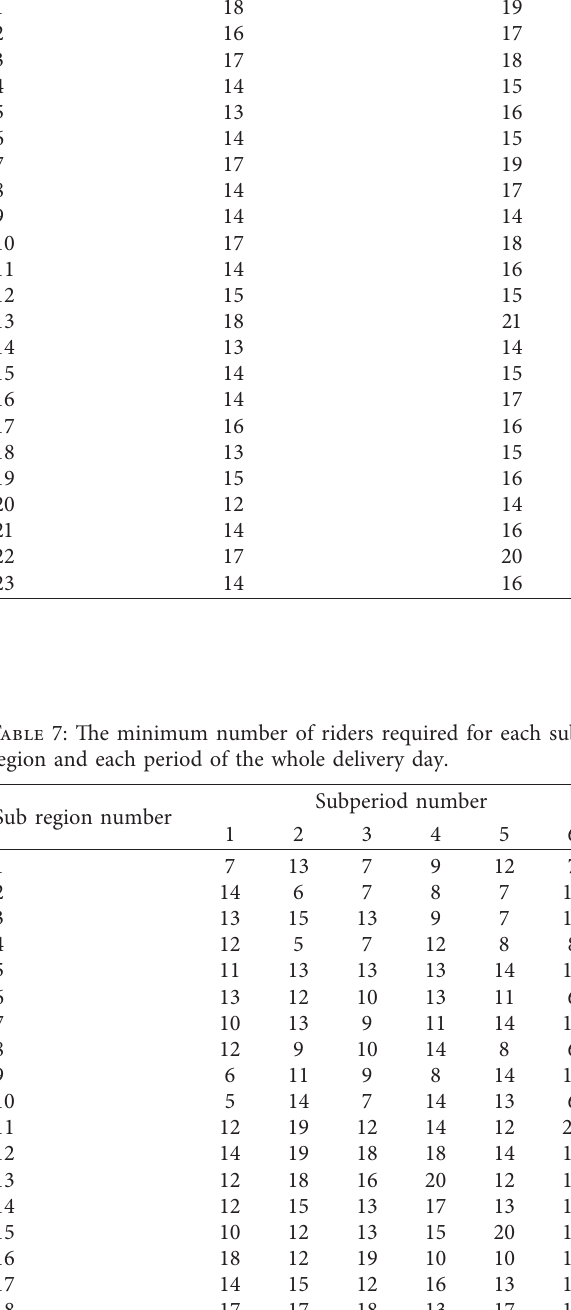
Table 8: Regional scheduling of some riders in each period. The rider number Sub region number